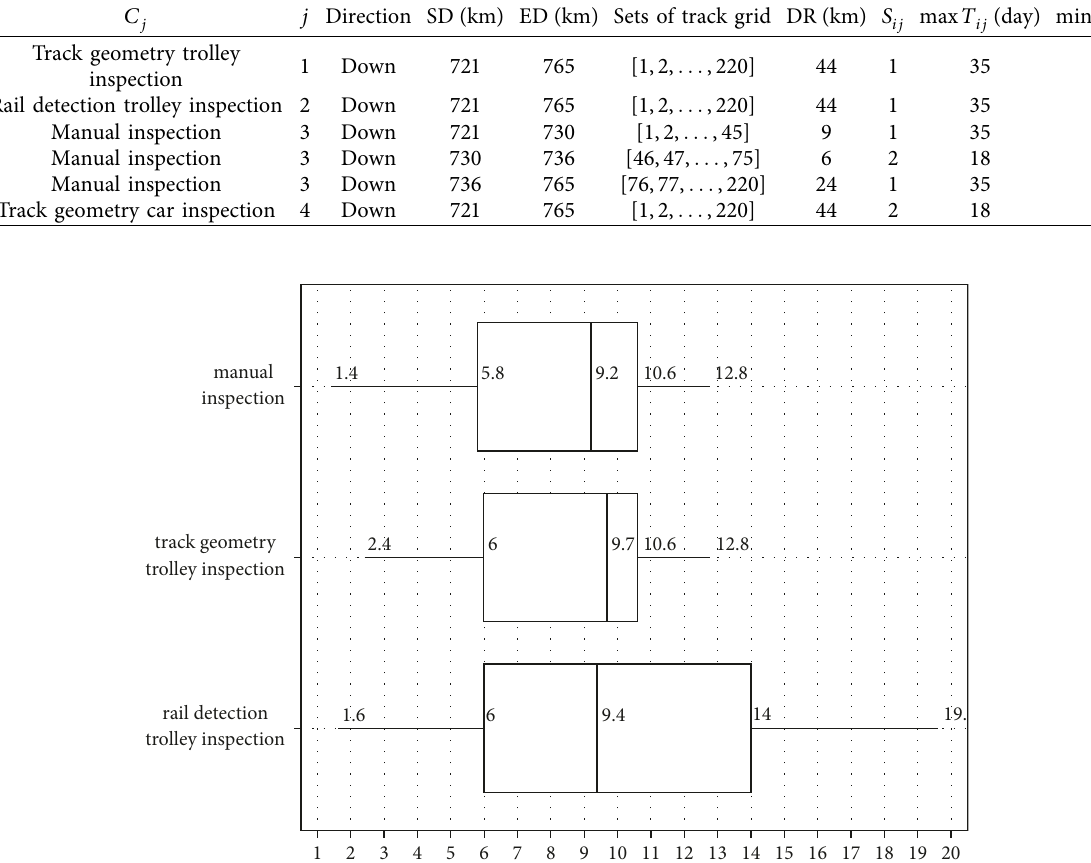
Table 2: Workload of track inspection activities for December 2016 in the Lanxin railway.